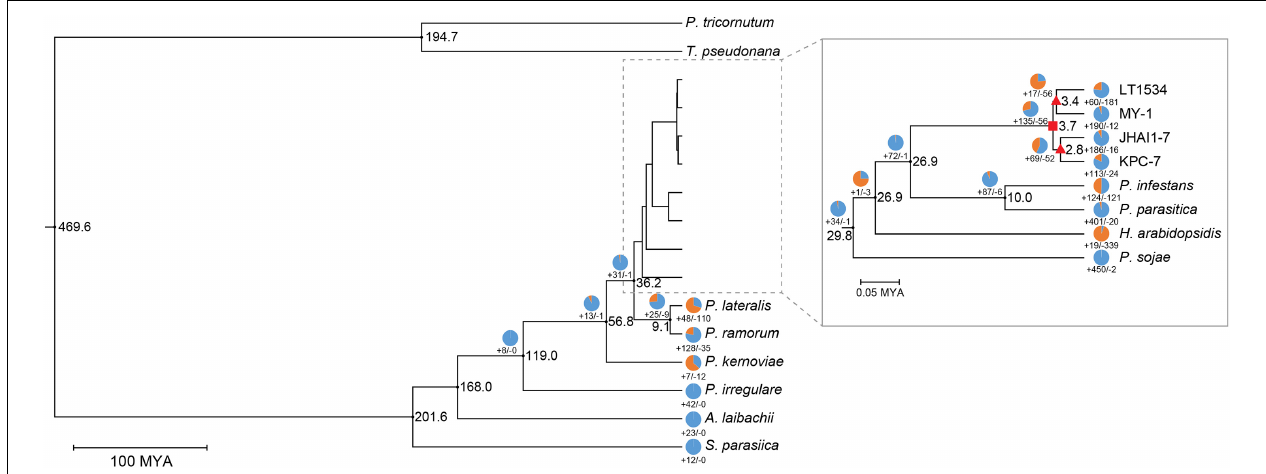
FIGURE 4 | Phylogenetic relationships among oomycetes. The numbers at each node represent the estimated divergence time of the oomycete species from MCMCTree results. The circles and their associated numbers indicate the expansion/contraction in the number of significantly overrepresented gene families. Rectangle in nodes indicates the P. capsici -specific node, while triangles in nodes denotes the common ancestors of low (LT1534 and MY-1) and high (JHAI1-7 and KPC-7) aggressive